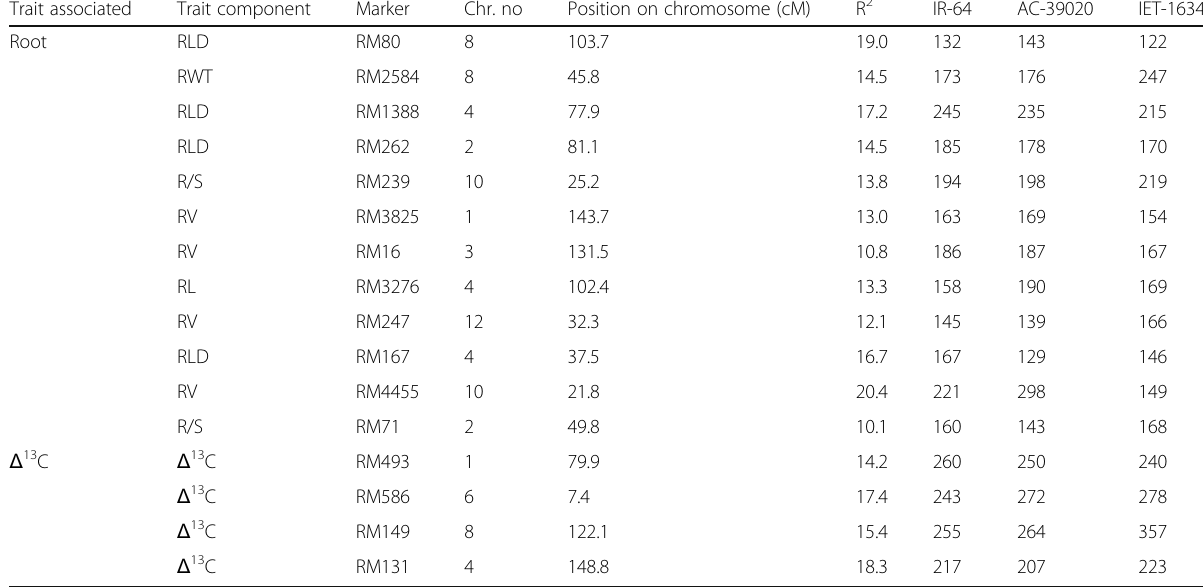
Table 1 List of markers associated with specific target trait used for Foreground selection Trait associated Trait